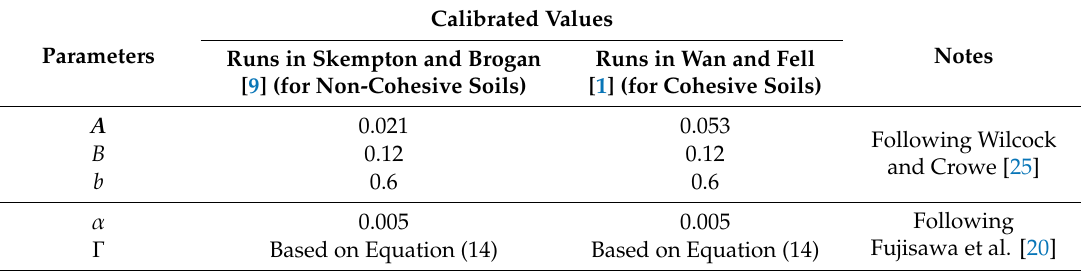
Table 1. Details of parameter